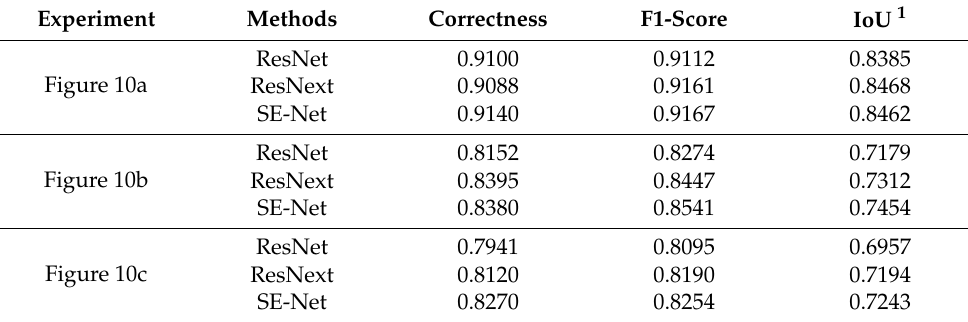
Table 3. Quantitative comparison of three backbone networks for the testing dataset.